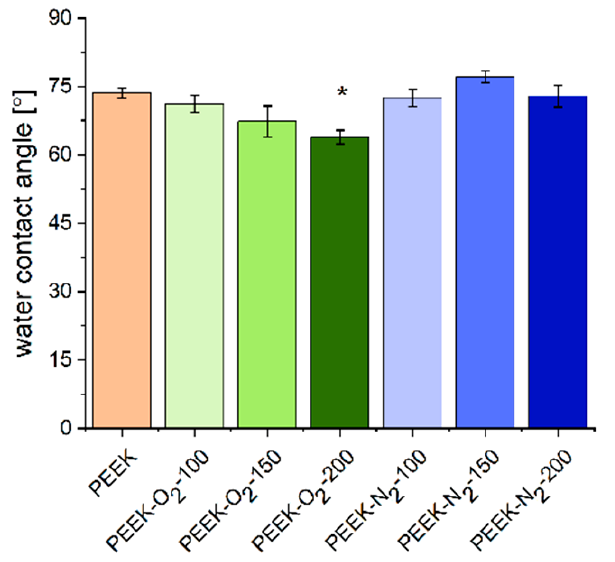
Figure 7. Water contact angle (WCA) measured for analyzed surfaces: non-modified and modified PEEK. MV ± SD, n = 9, * p < 0.05 vs. control (PEEK).